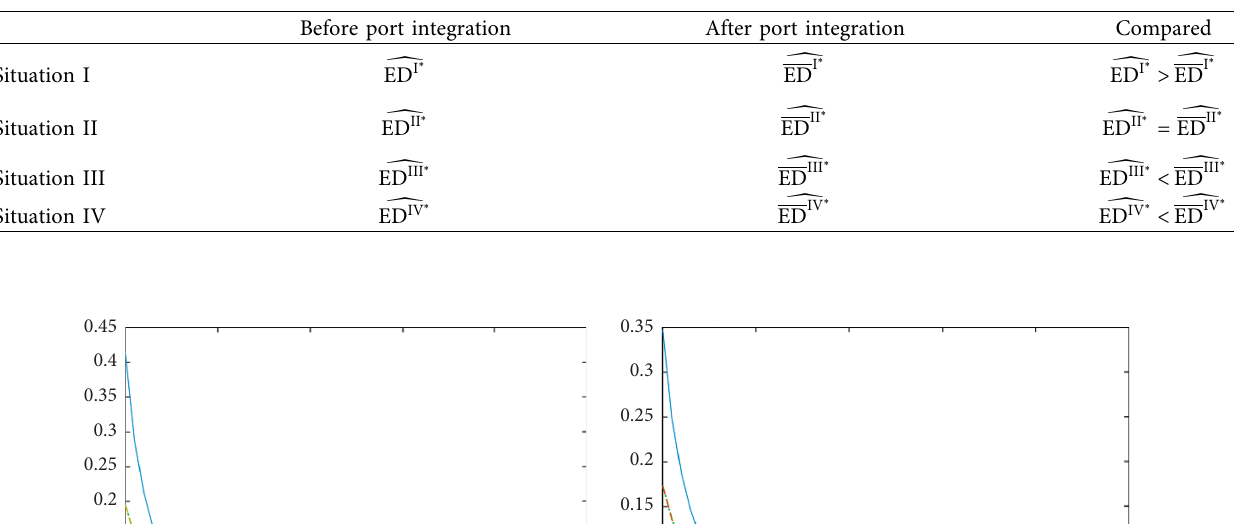
Table 3: Comparison of balanced carbon emissions before and after port integration.